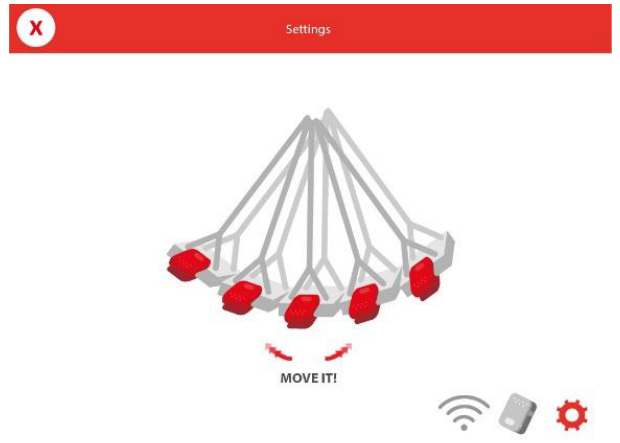
Figure 12. Instructions on how to trigger interaction with the swing.